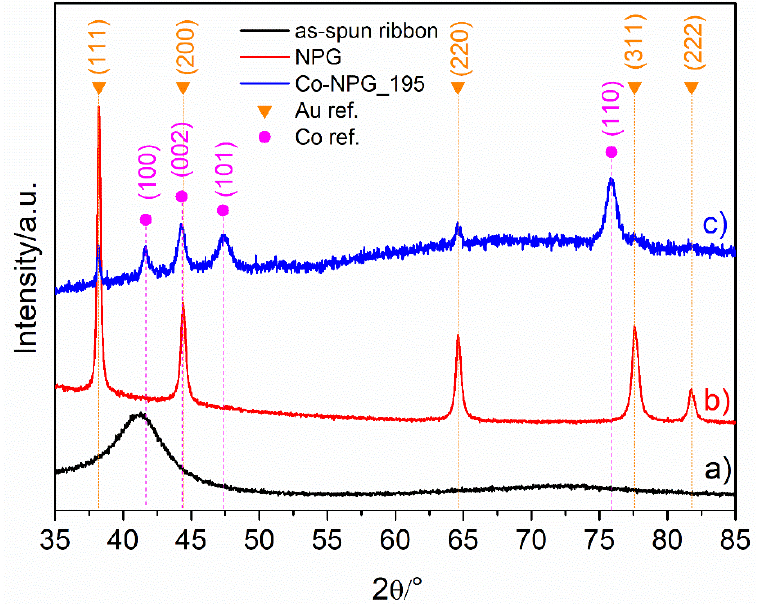
Figure 7. XRD patterns given by the as-spun ribbon ( a ), NPG ( b ) and Co-NPG_195 ( c